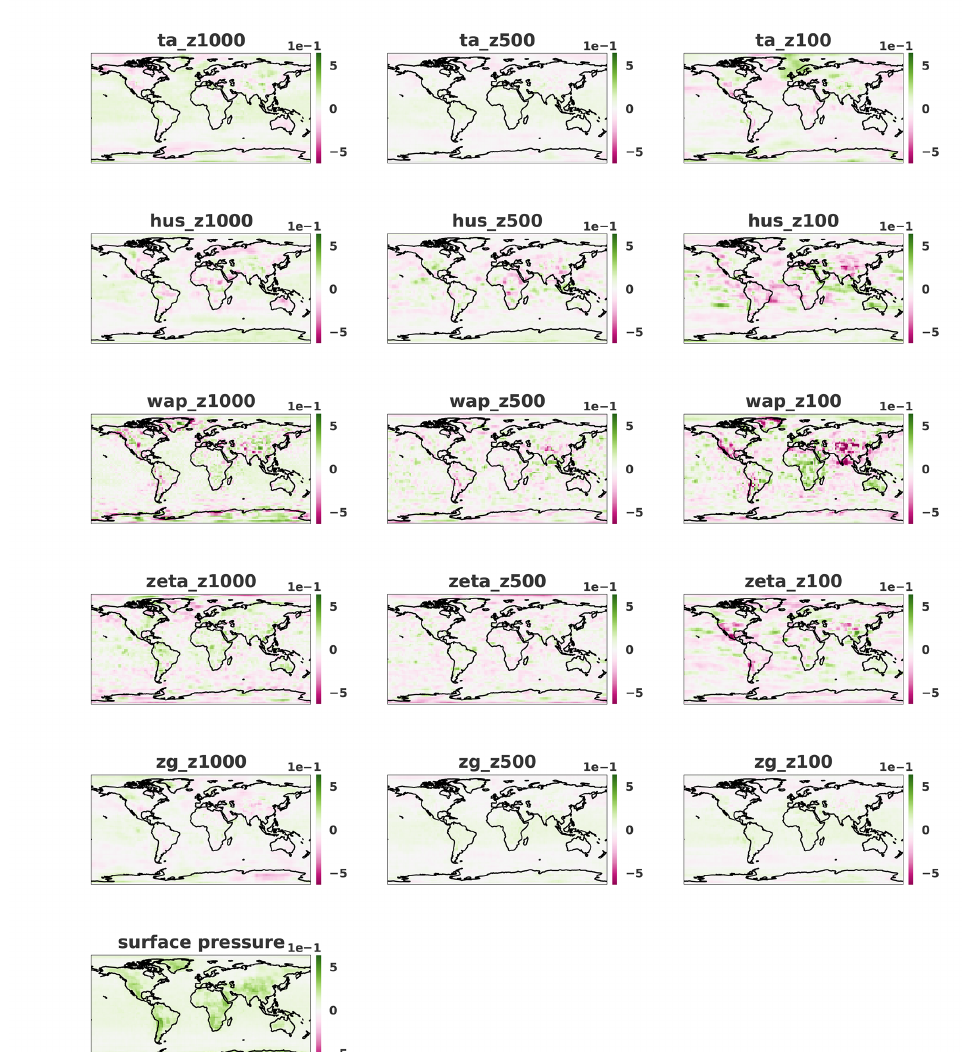
Figure 11. Standard deviation error over 30 years of the normalized dataset and the same number of normalized generated samples on three different pressure levels (1000, 500 and 100hPa). The samples were horizontally transposed in order to have Europe at the center of the images. Coastlines were added a posteriori for